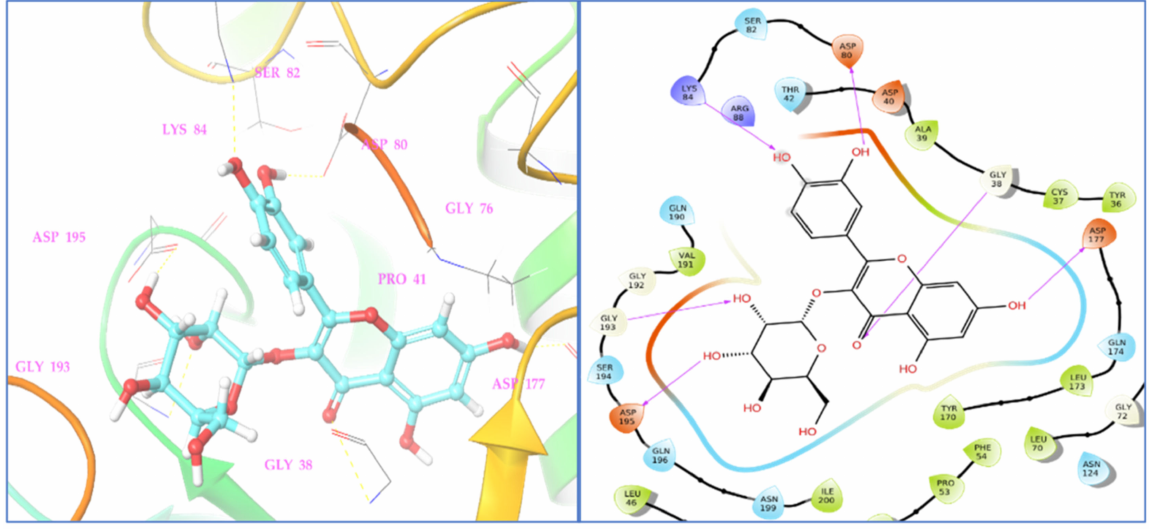
Figure 7. Two- and three-dimensional residual interactions network of hyperoside against the active site of TyrRS protein (PDB ID: